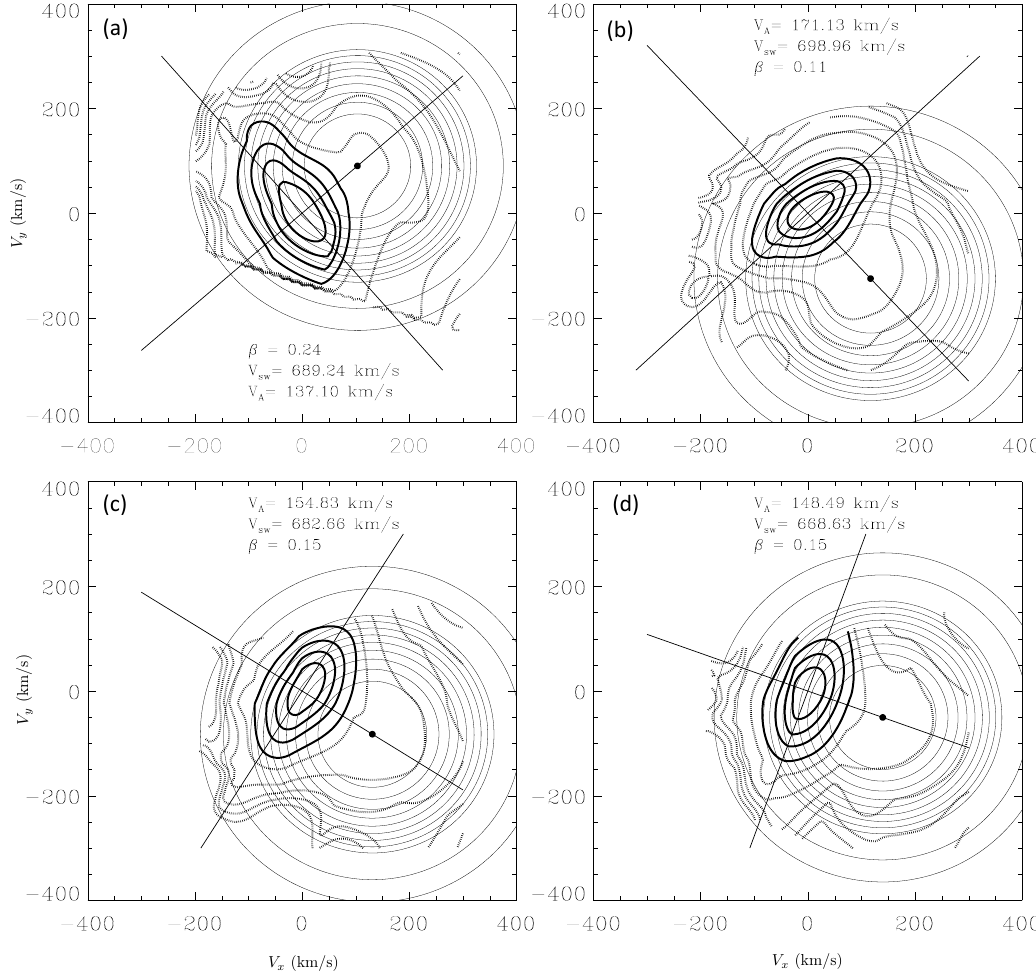
Fig. 2. Proton velocity distribution functions in fast solar wind, presented in the same format as in the previous figure. Note, however, the stronger and more pronounced beams and their higher temperatures, which are apparent by the wide almost circular bulges. The mea- surements of the VDFs were made on 14 April 1976 at the times (hours:minutes:seconds): (a) 20:38:13, (b) 22:02:35, (c) 23:09:27, and (d) 23:10:08. All data correspond to a heliocentric distance of